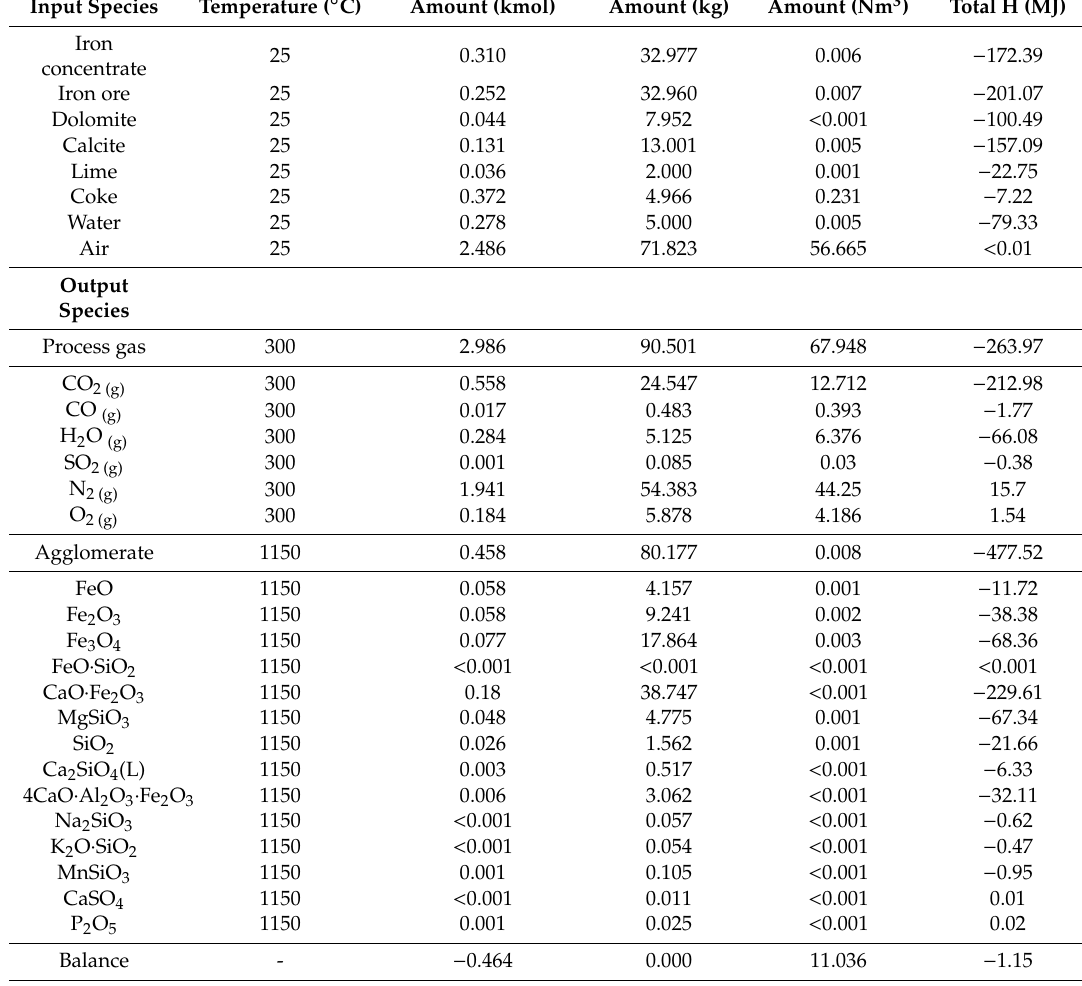
Table 7. Mass and thermal balance of mixture sintering process (calculation for 100 kg of